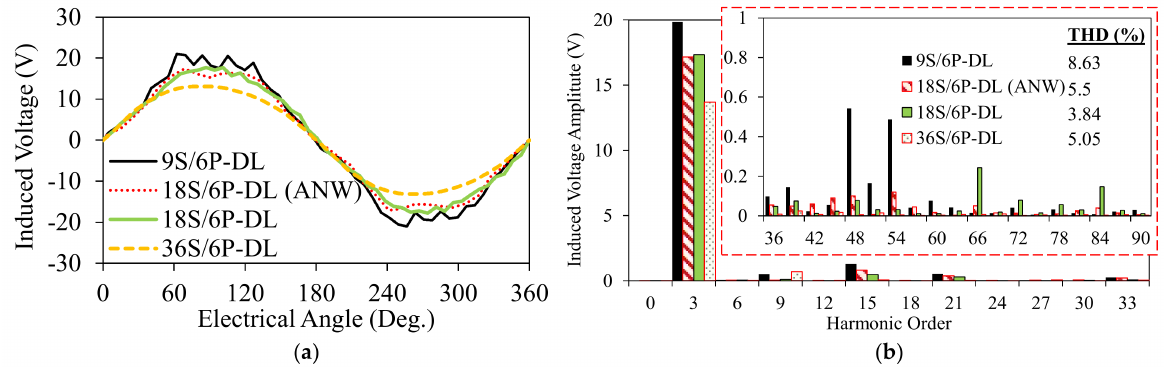
Figure 15. Induced voltage in phase ‘A’: ( a ) waveforms and ( b ) harmonic